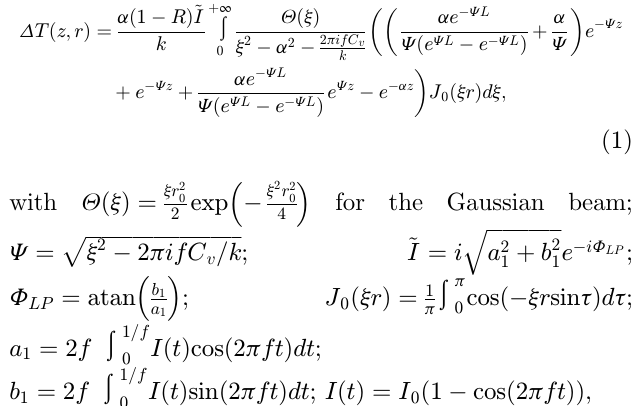
ffiffiffiffiffiffiffiffiffiffiffiffiffiffiffiffiffiffiffiffiffiffiffiffiffiffiffiffiffiffi p ffiffiffiffiffiffiffiffiffiffiffiffiffiffiffi j 2 (cid:2) 2 p ifC = k v